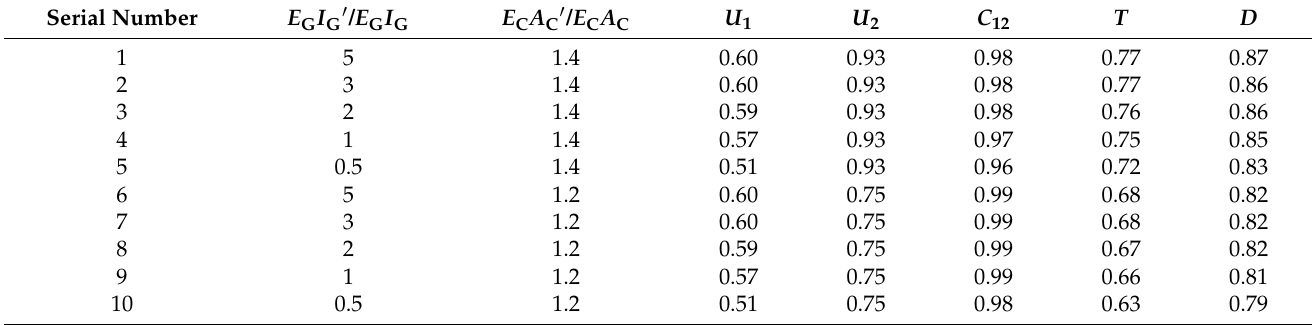
Table 7. Calculated results of stiffness coupling coordination between main girder and stayed